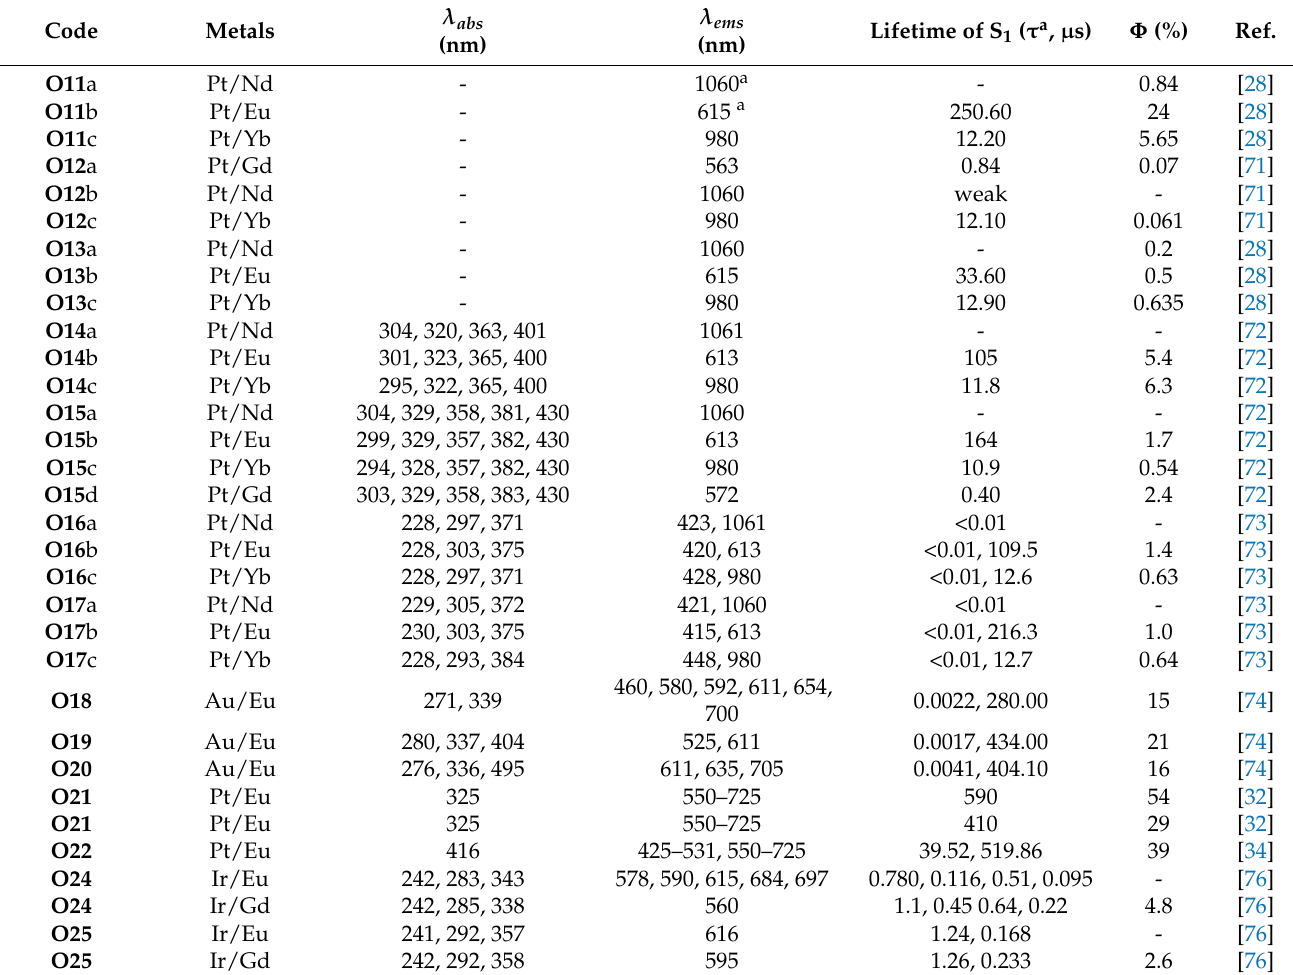
Figure 13. “ d - f - d ” type Eu(III)-co-ordinated Pt(II) di-ynes. Table 4. Photoluminescence data of heterometallic metalla-ynes O11 − O22 and O24 − O29 .